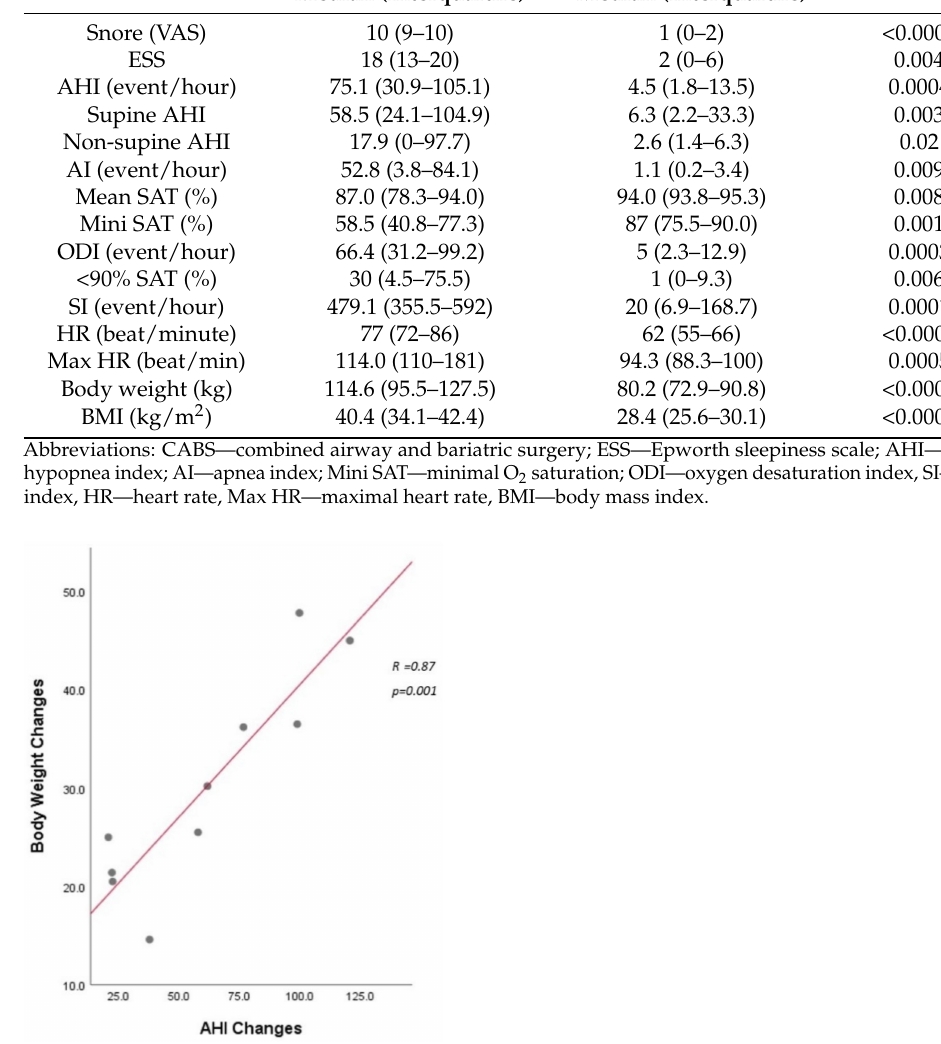
Figure 7. Changes in apnea–hypopnea index (AHI) are significantly correlated with changes in body weight (r = 0.87, p = 0.001) after combined airway and bariatric